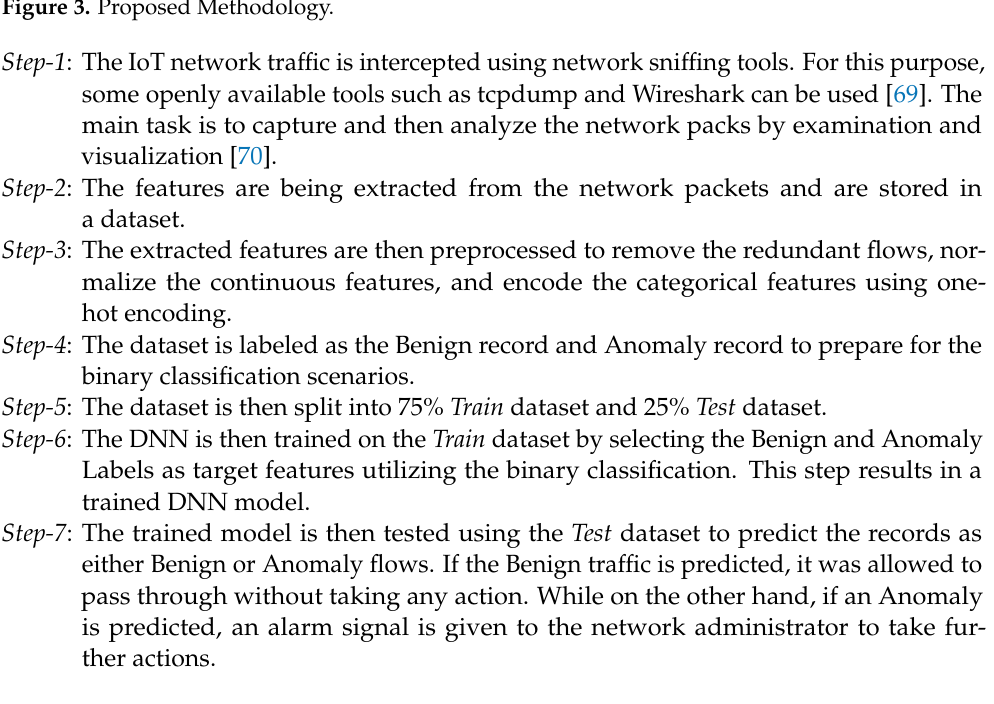
Figure 3. Proposed Methodology.